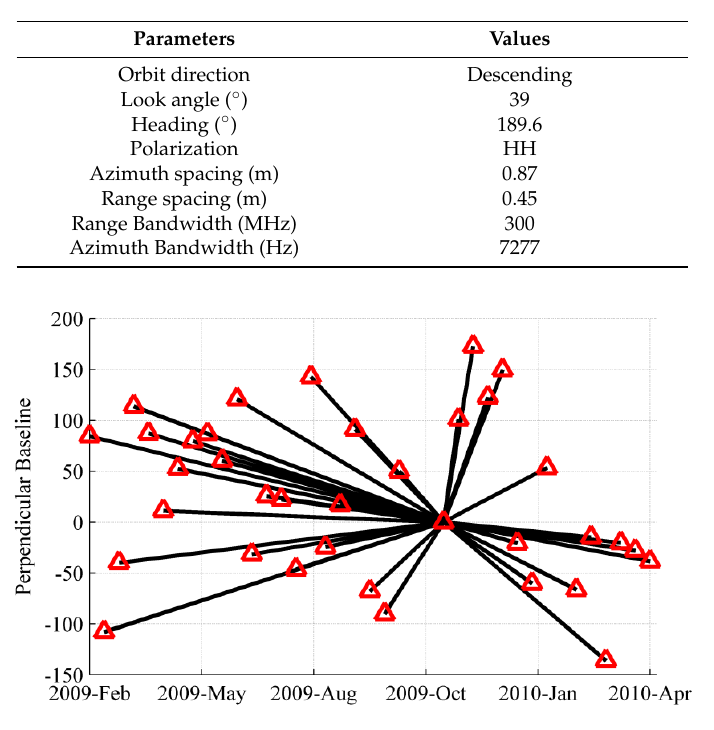
Figure 2. Temporal and perpendicular baseline distributions. Table 1. Basic information for high resolution spotlight TerraSAR-X datasets.